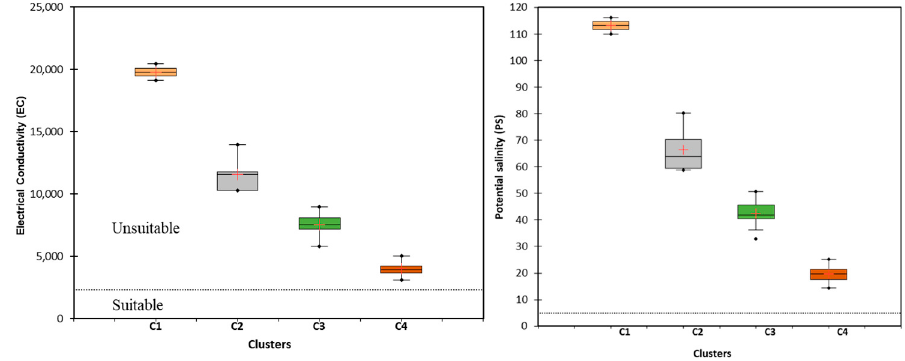
Figure 7. Plot depicting the variation in EC and PS indices of GW for the four clusters (C1, C2, C3, and C4) (+ represent the median values) .